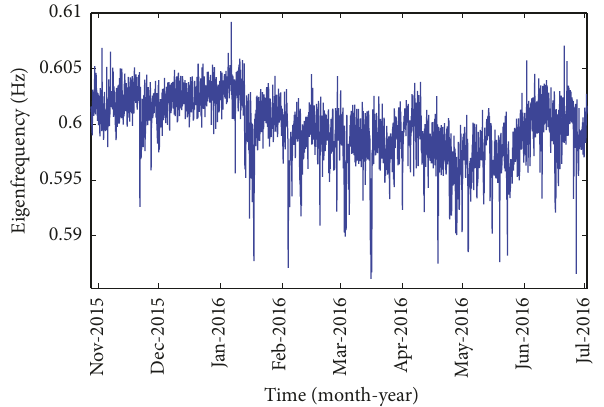
Figure 9: Time trend of the third eigenfrequency.